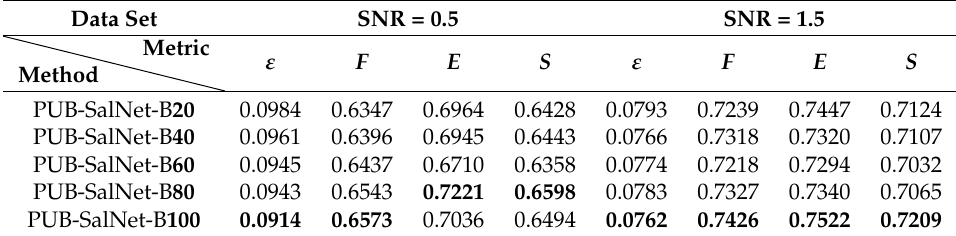
Table 3. The quantitative comparison of parameter sensitivity analysis under four metrics. ε , F , E and S are the same as Table 1. For PUB-SalNet-B X , X stands for the initial number of classes to be decreased, as is in Function Init() parameter in Algorithm